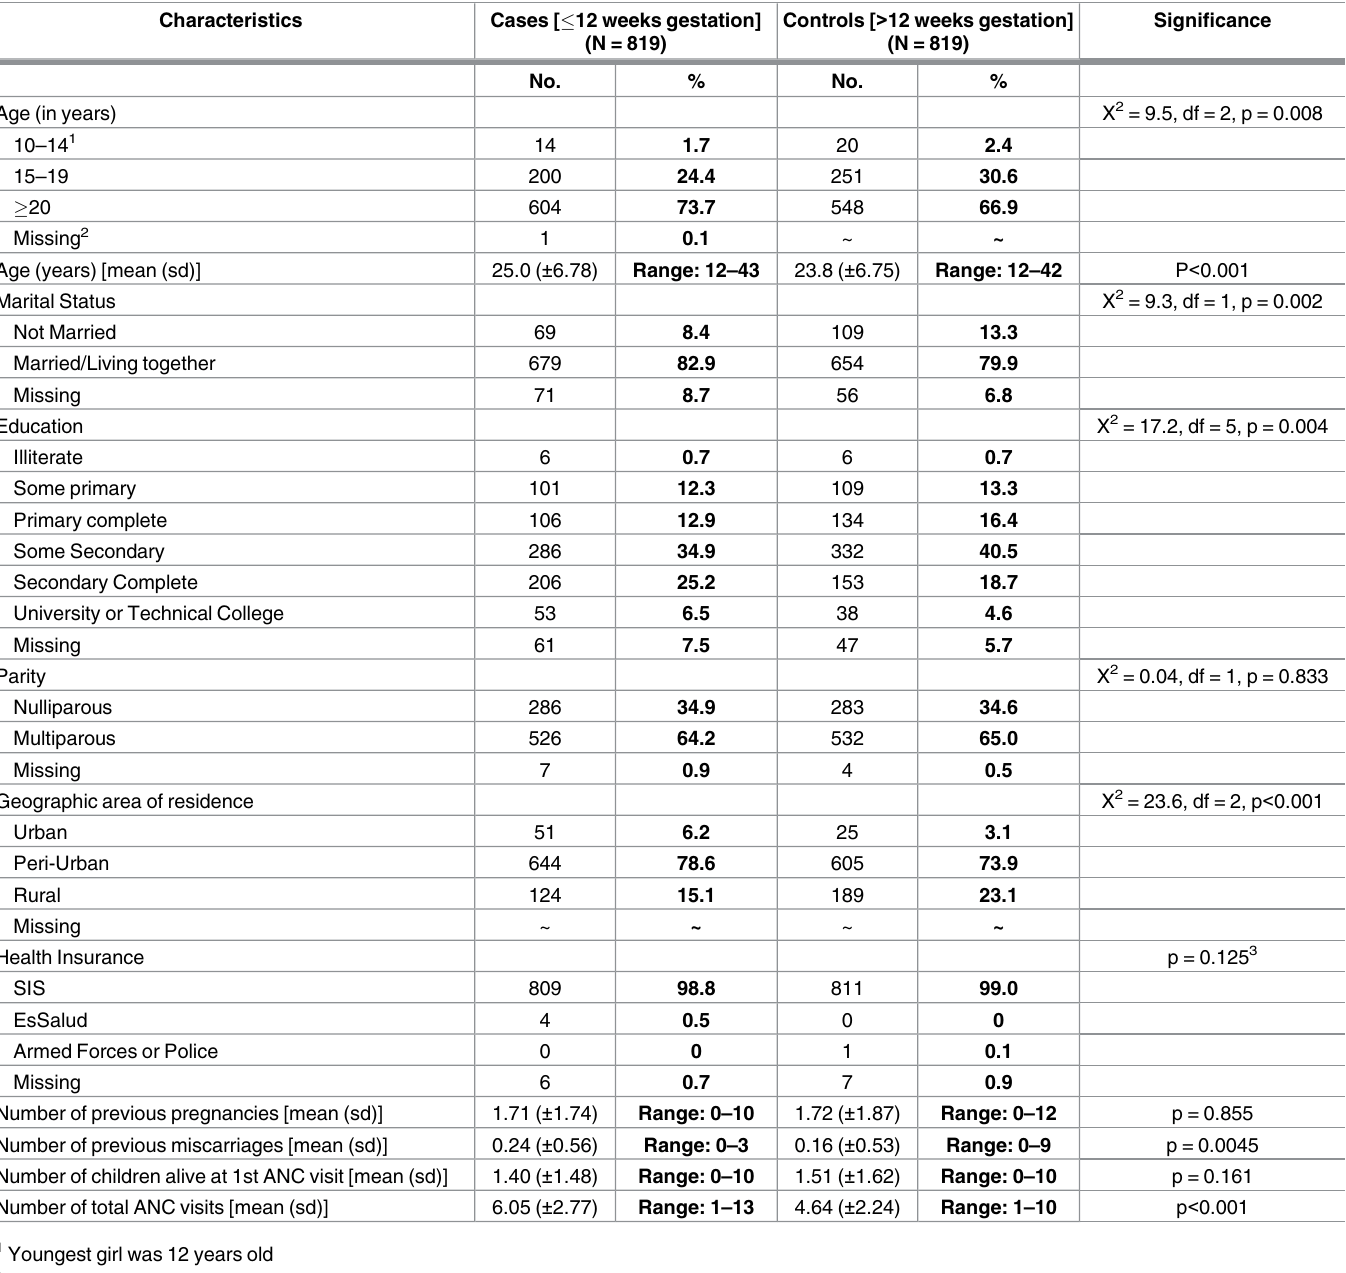
Table 1. Characteristics of pregnant women who attend their first 1 st ANC visit in the 1 st trimester of pregnancy (cases)and of pregnant women who first attend in the 2 nd or 3 rd trimester (controls), Bele´n, Iquitos, Peru, 2010–2012.